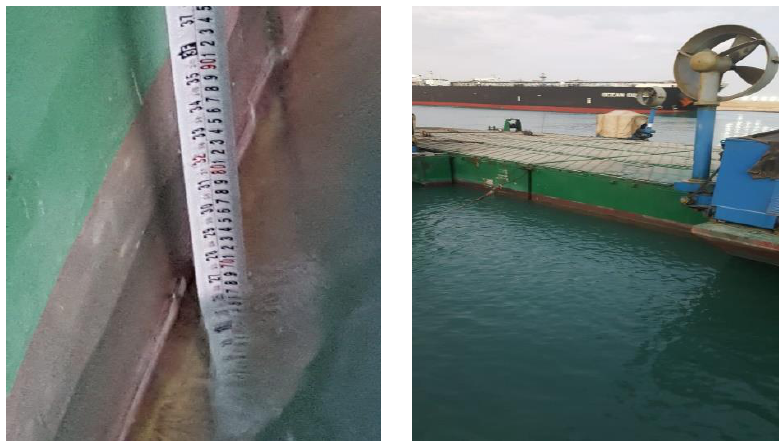
Figure 9. The draft of the ferry under its own weight measured at the field.